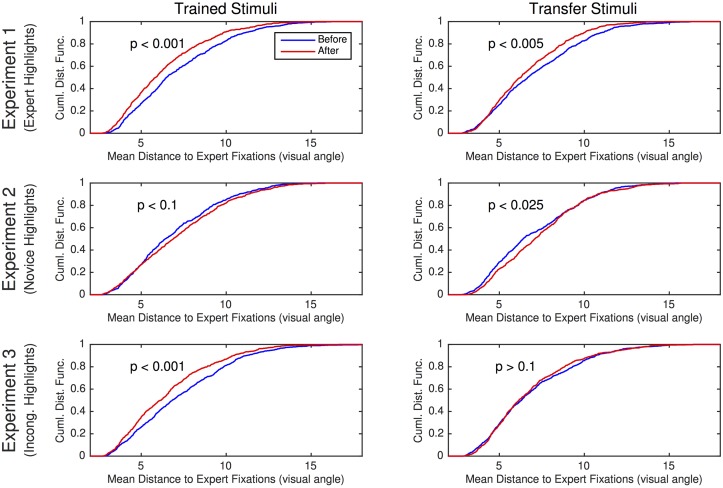
Summary of spatial proximity results from Experiments 1–3.Each experiment is shown in a row of the figure. The left and right columns present results for trained and transfer stimuli, respectively. Each graph shows the empirical cumulative distribution function before (blue) and after (red) the training phase. Each sample in the cumulative distribution function derives from the mean distance to all expert fixations (on the same image and impression) for a given subject fixation. Experiment 1–3 involved highlighted training based on expert fixations, novice fixations, and incongruent expert fixations, respectively.